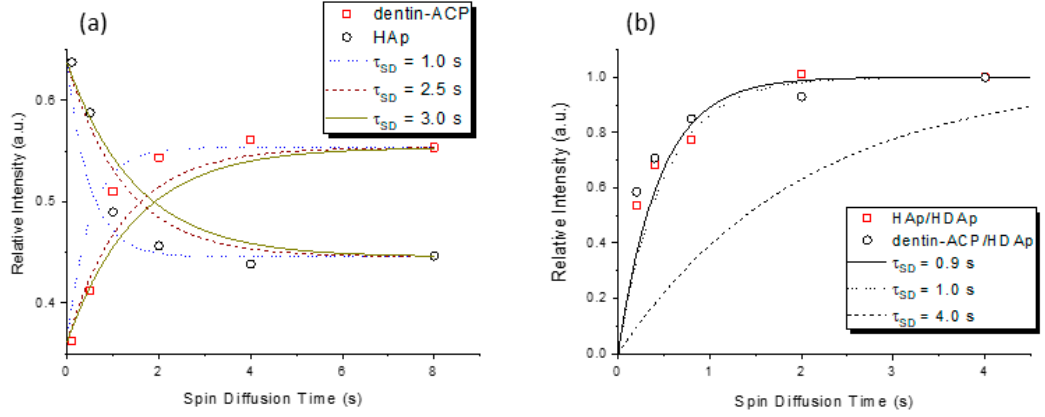
Figure 6. Experimental data of the 31 P spin di ff usion experiments. The simulations were carried out as described in [10] and [17]. ( a ) Results obtained for the transfer between the HAp and the dentin-ACP phases, for which the first CP contact time was set to 12 ms to enhance the initial HAp signal; ( b ) the spin di ff usion time constant ( τ SD ) extracted for the transfer between HAp and HDAp was similar to that for the transfer between dentin-ACP and HDAp.